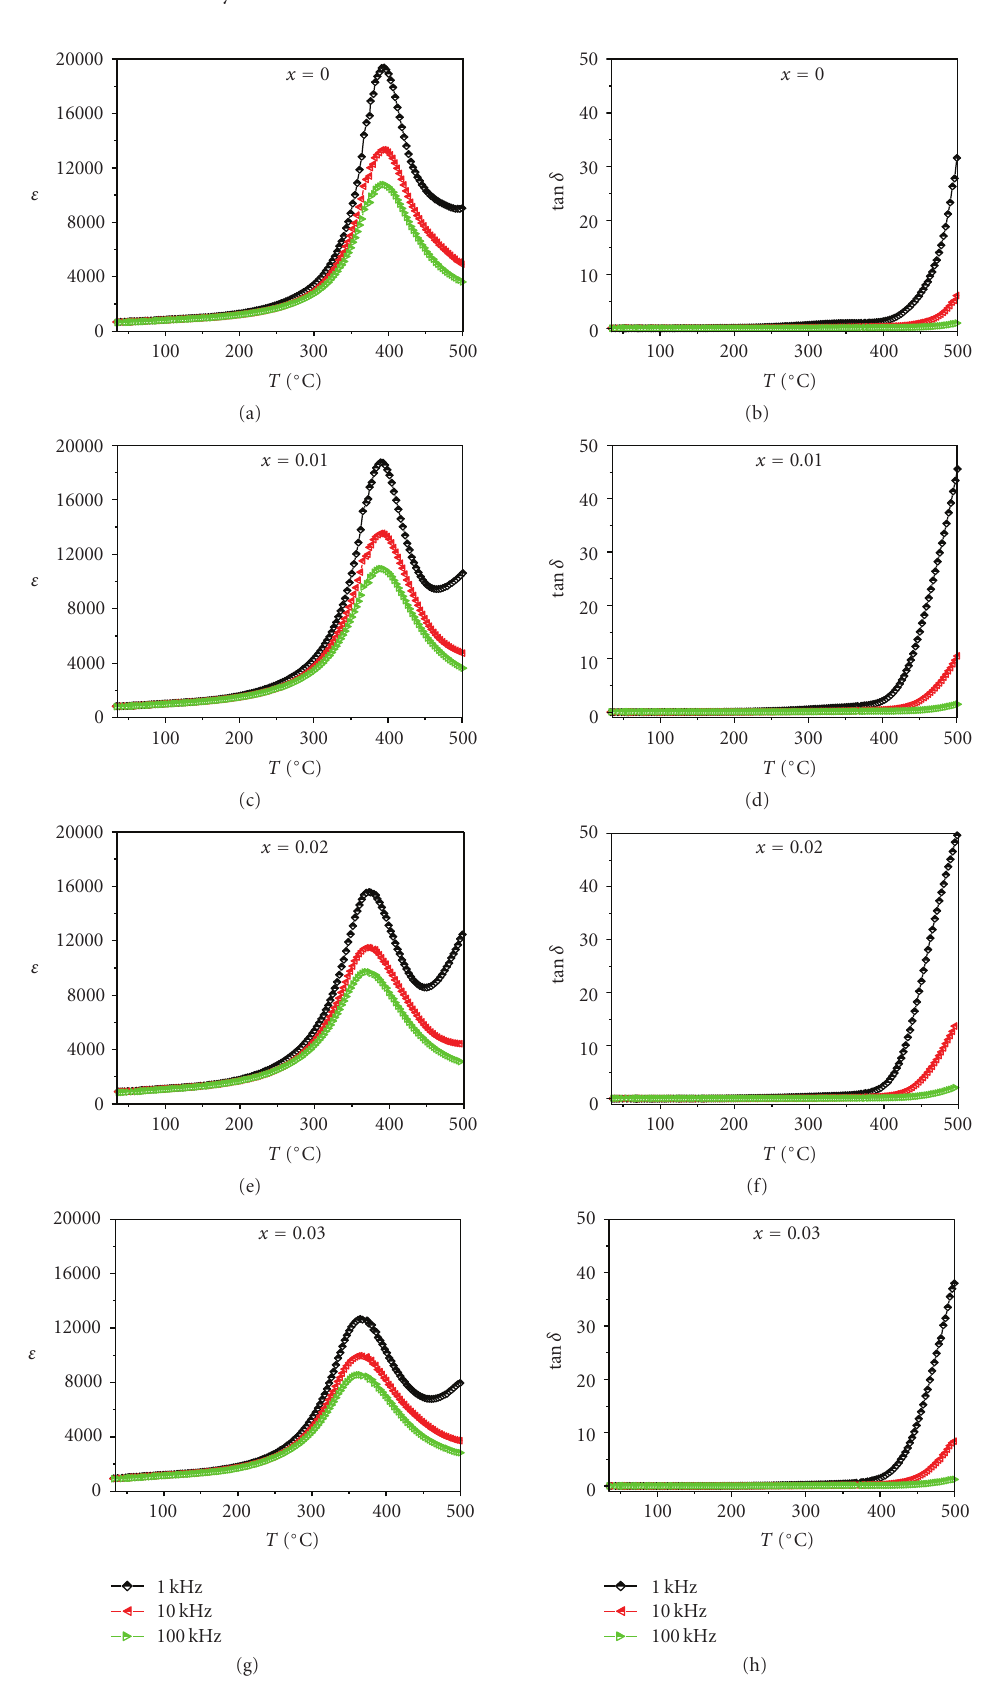
Figure 3: Variation of dielectric constant and loss tangent with